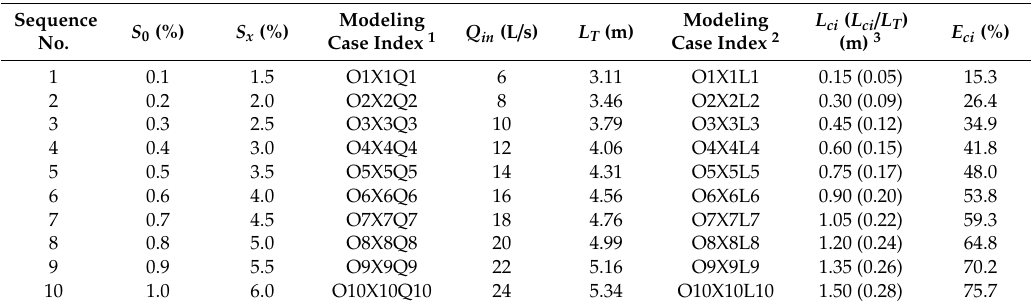
Table 1. Sequence numbers and corresponding geometry and inflow parameters of modeling cases used for FullSWOF-ZG simulations, and the results for the 20 sample